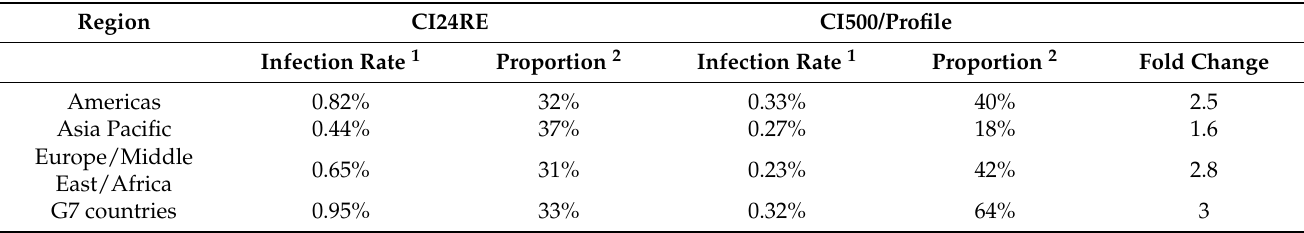
Table 1. Percentage of infections leading to explant by geographical region (2010–2020).